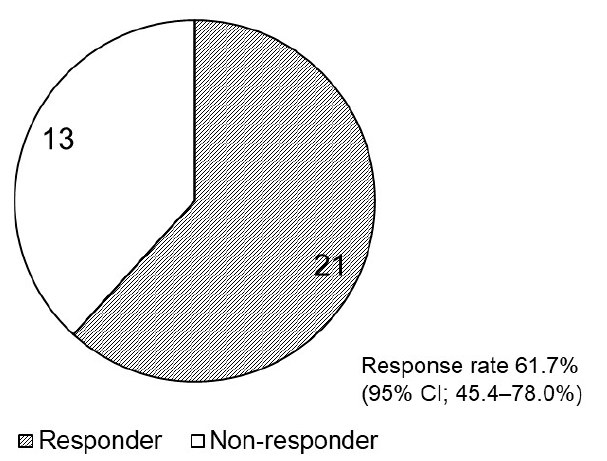
Figure 1. Pie chart presenting the number of responders and non-responders after naldemedine initiation. CI, confidence interval (CI). Table 3. Patient backgrounds based on response.